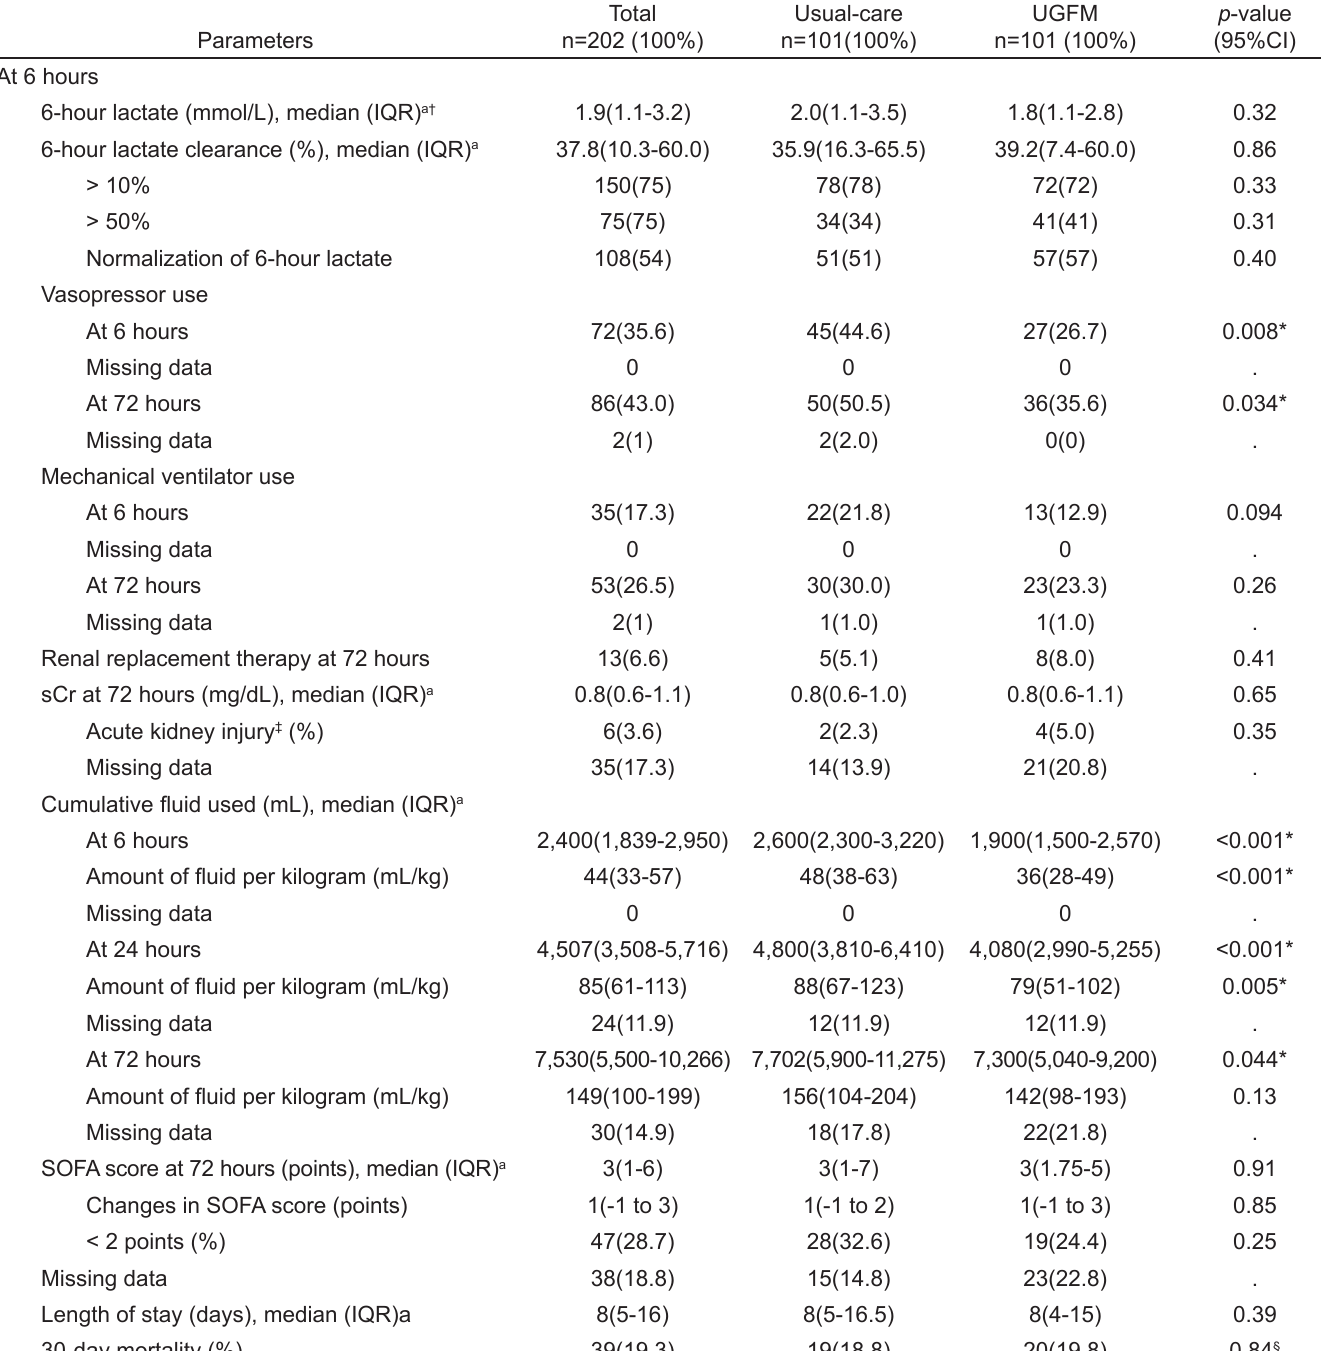
Table 2. Results of the patient cohort and comparisons between treatment